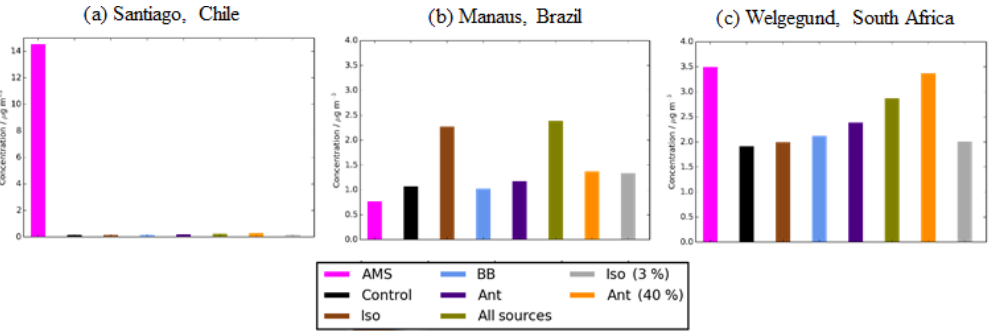
Figure 13. Simulated and observed OA surface concentrations (µgm − 3 ) over an urban environment, (a) Santiago (Chile), and the remote environments of (b) Manaus (Brazil) and (c) Welgegund (South Africa). Bars indicate observed (pink) and simulated OA surface concentra- tions from the control (black), Iso (brown), BB (light blue), Ant (dark blue), AllSources (green), Ant (40%) (yellow), and Iso (3%) (grey). Model simulations are described in Table